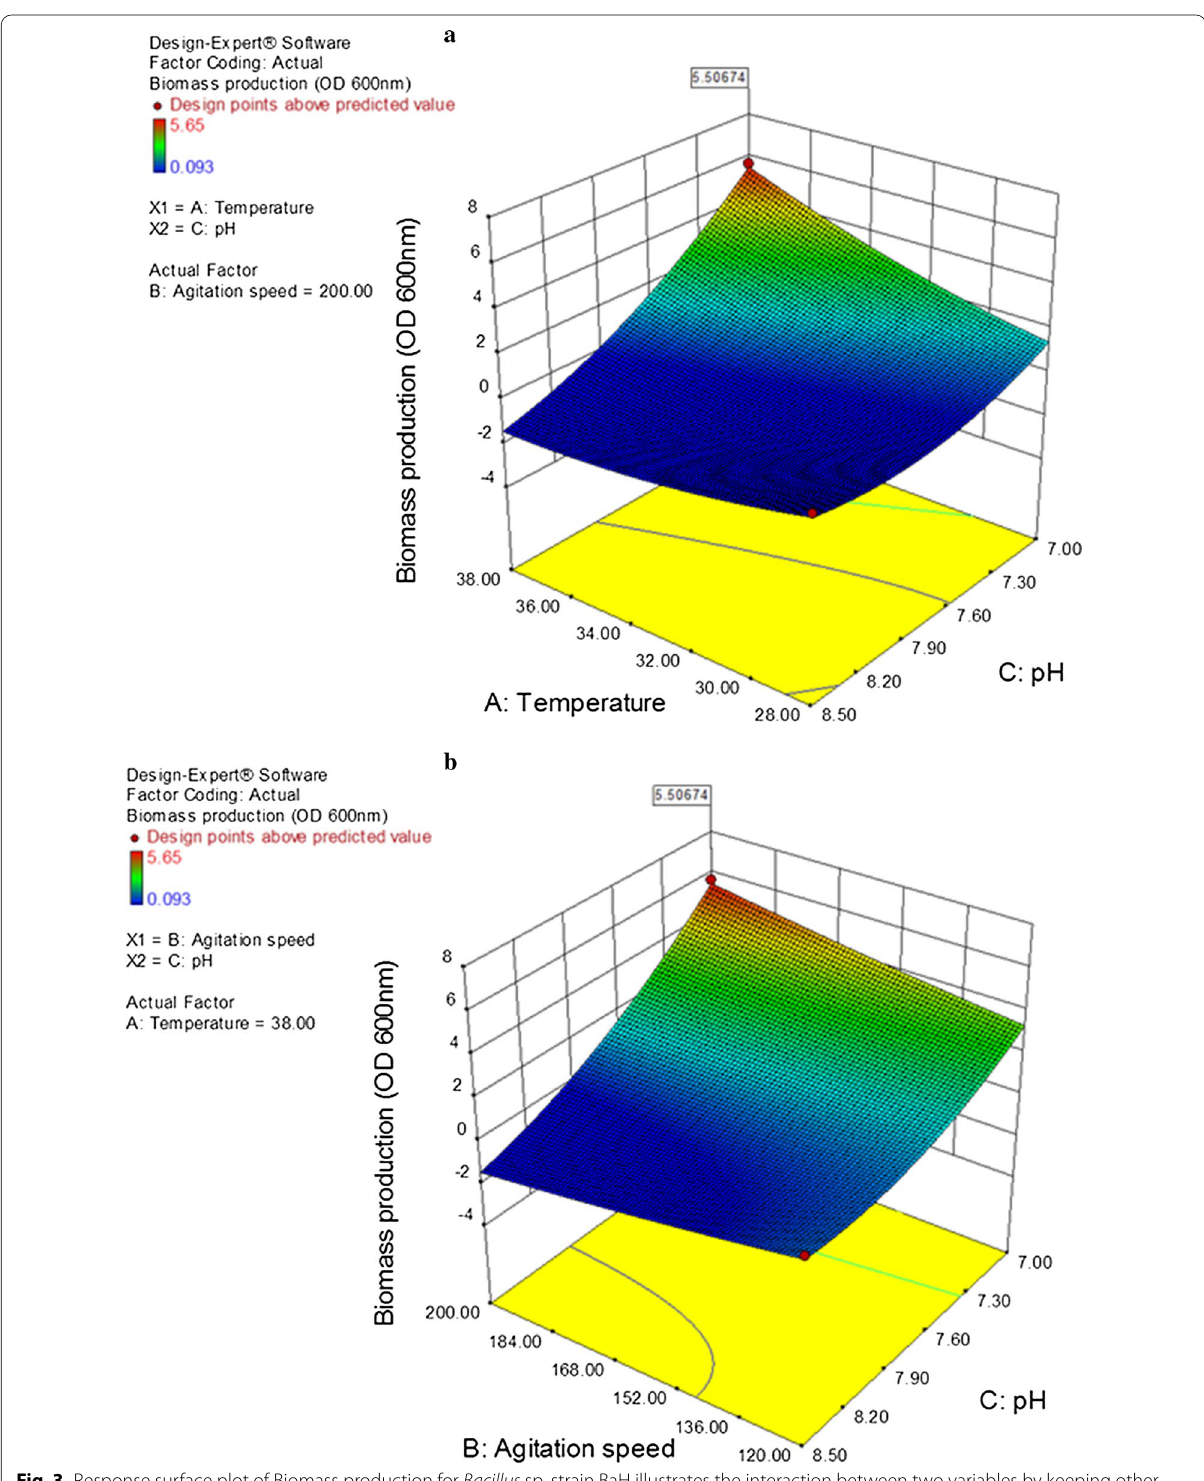
Fig. 3 Response surface plot of Biomass production for Bacillus sp. strain BaH illustrates the interaction between two variables by keeping other one constant. a Interaction between temperature and pH while agitation speed is 200 rpm; b interaction between agitation speed and pH while temperature is 38